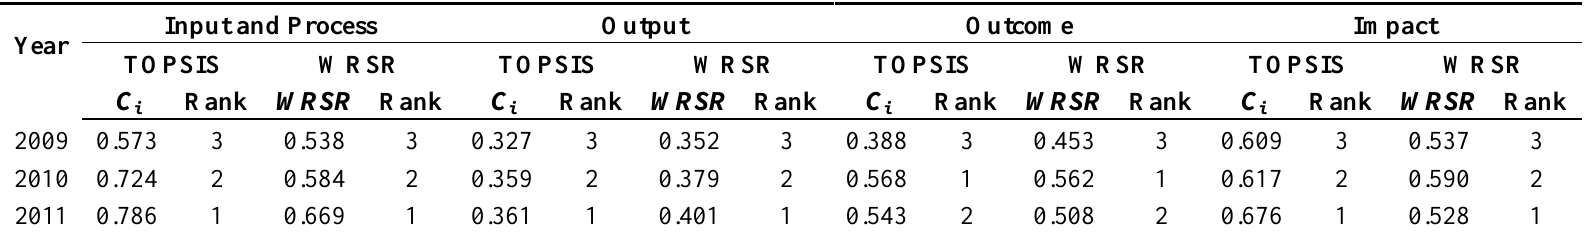
Table 5. Rankings for performance evaluation of healthcare reform in Hubei Province 2009–2011.